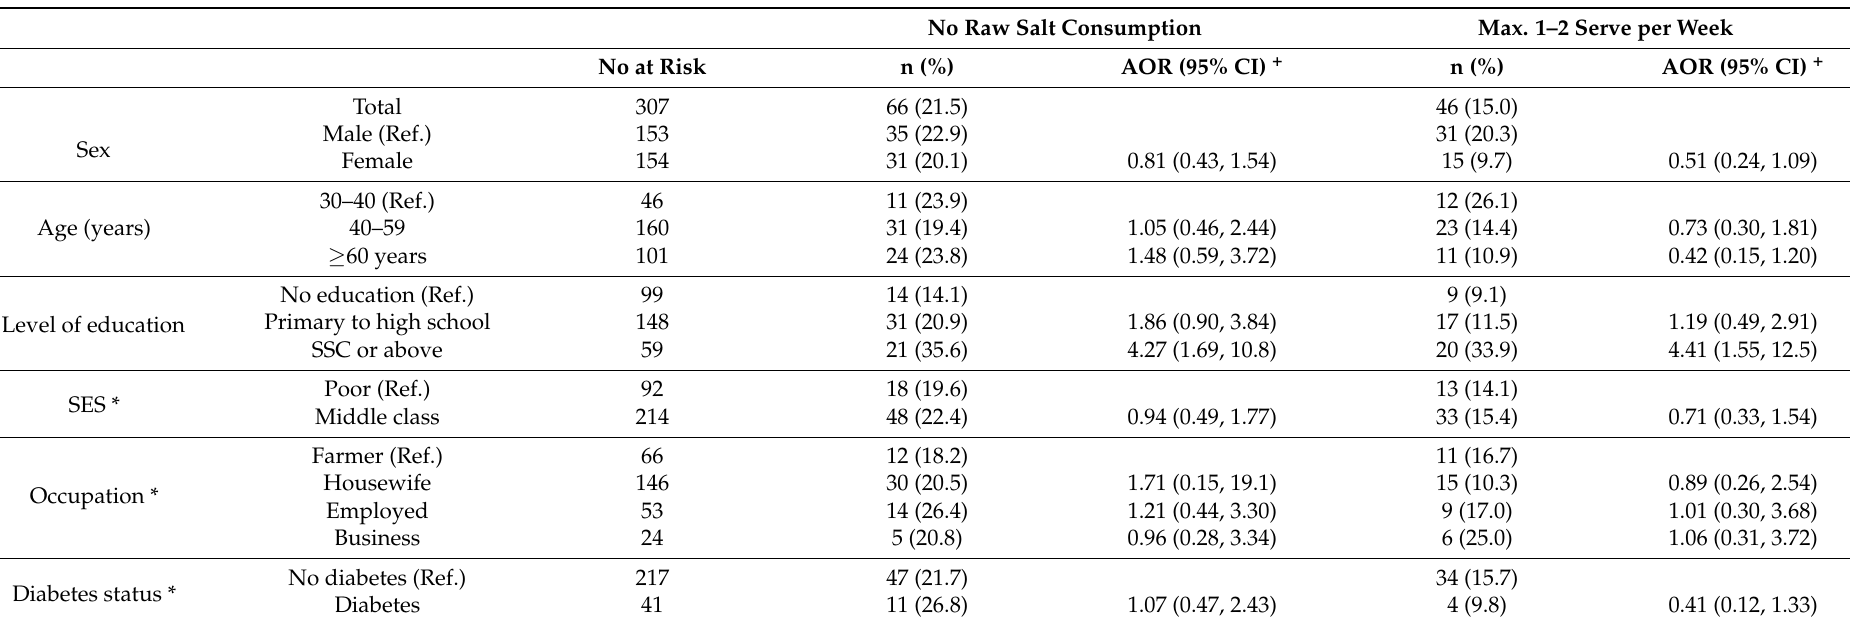
Table 4. Associations of sociodemographic, occupation, and diabetes status with no raw salt consumption and fruit intake maximum 1–2 serves in a week using logistic regression from a cluster RCT in a rural area in